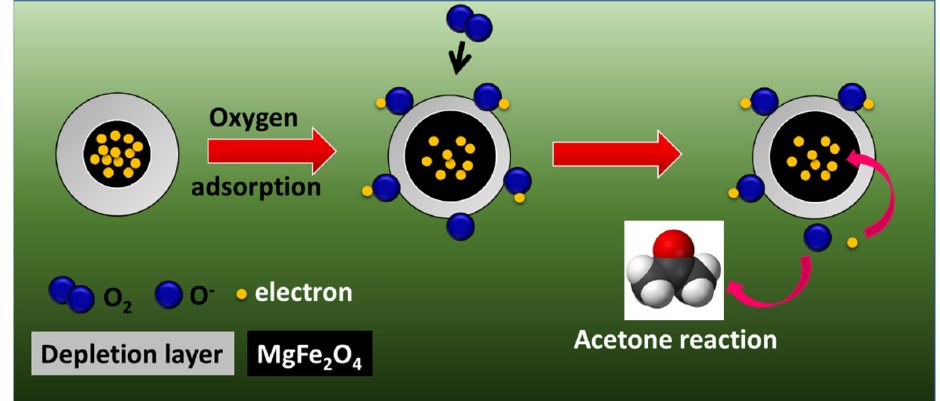
Figure 9. Schematic illustration of acetone gas-sensing mechanism of MgFe 2 O 4